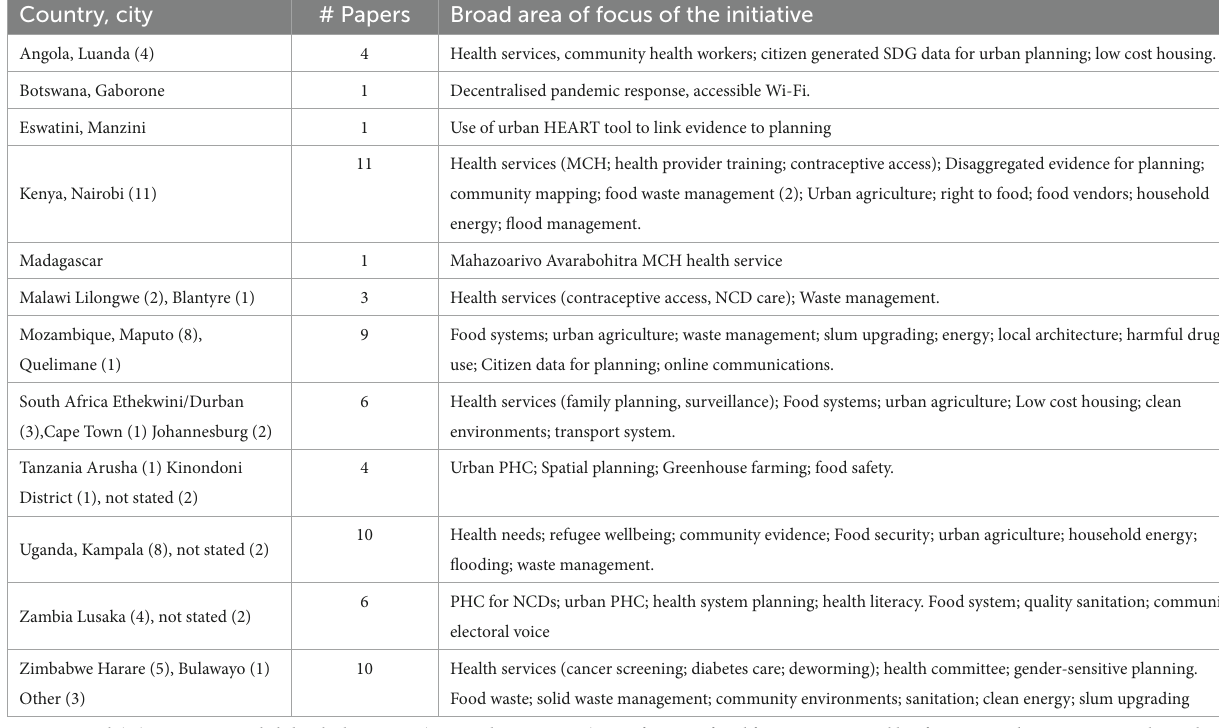
TABLE 1 Areas of focus of initiatives found in the desk review (frequencies in brackets). Country, city # Papers